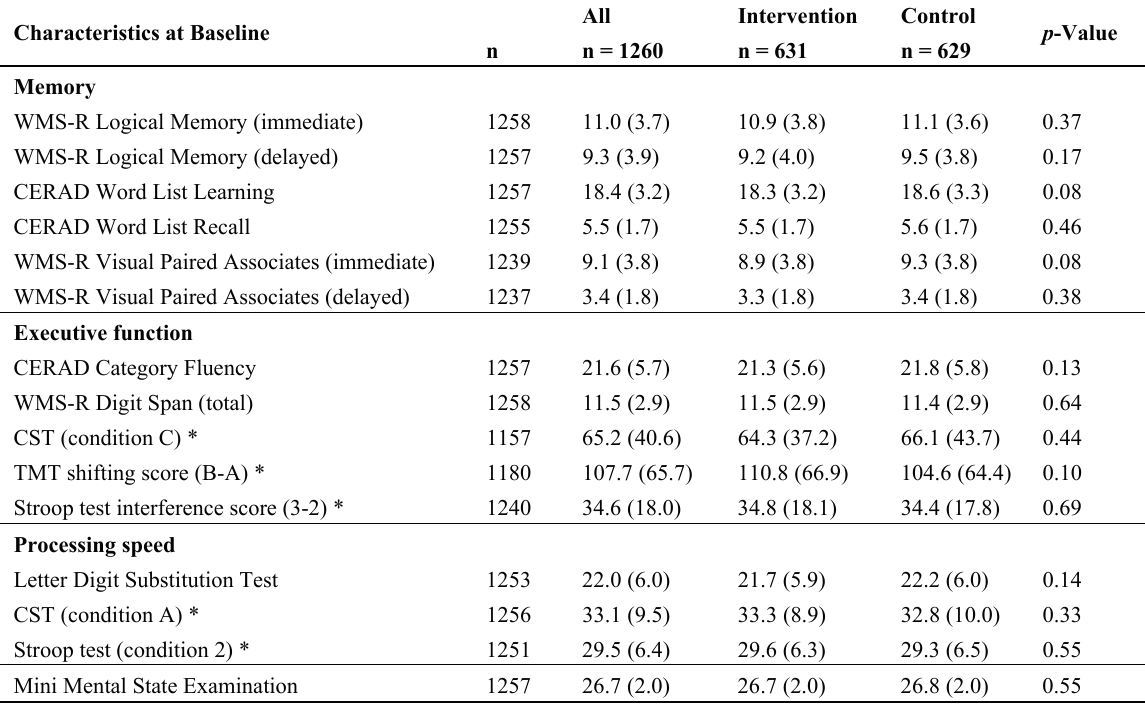
Table 4. Cognitive performance of the randomized participants and formation of the cognitive outcome modified Neuropsychological Test Battery (mean